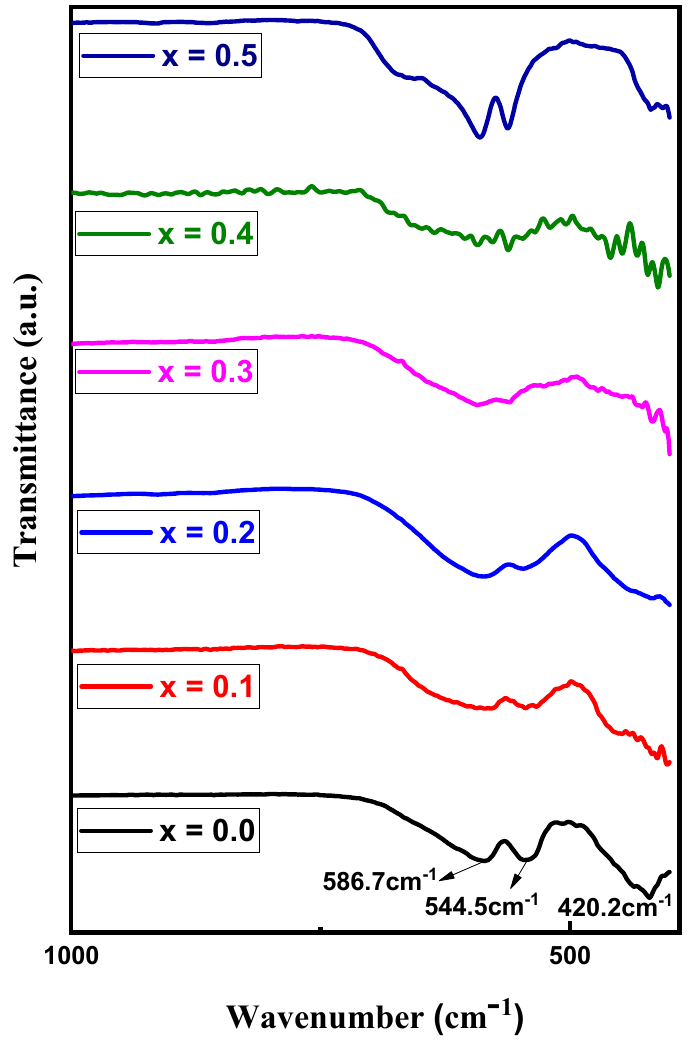
Figure 5. Fourier-transform infrared spectroscopy (FTIR) spectra of proposed Sr 1 − x Mn x Fe 12 − x Y x O 19 (0.0 ≤ x = y ≤ 0.5) nanohexaferrites.